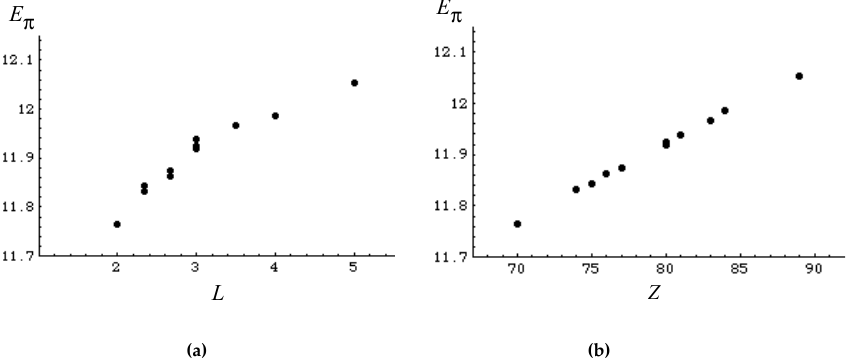
Figure 2. Correlation of E π ’s of eleven isomers of decapentaenes with L ( a ) and Z ( b ).